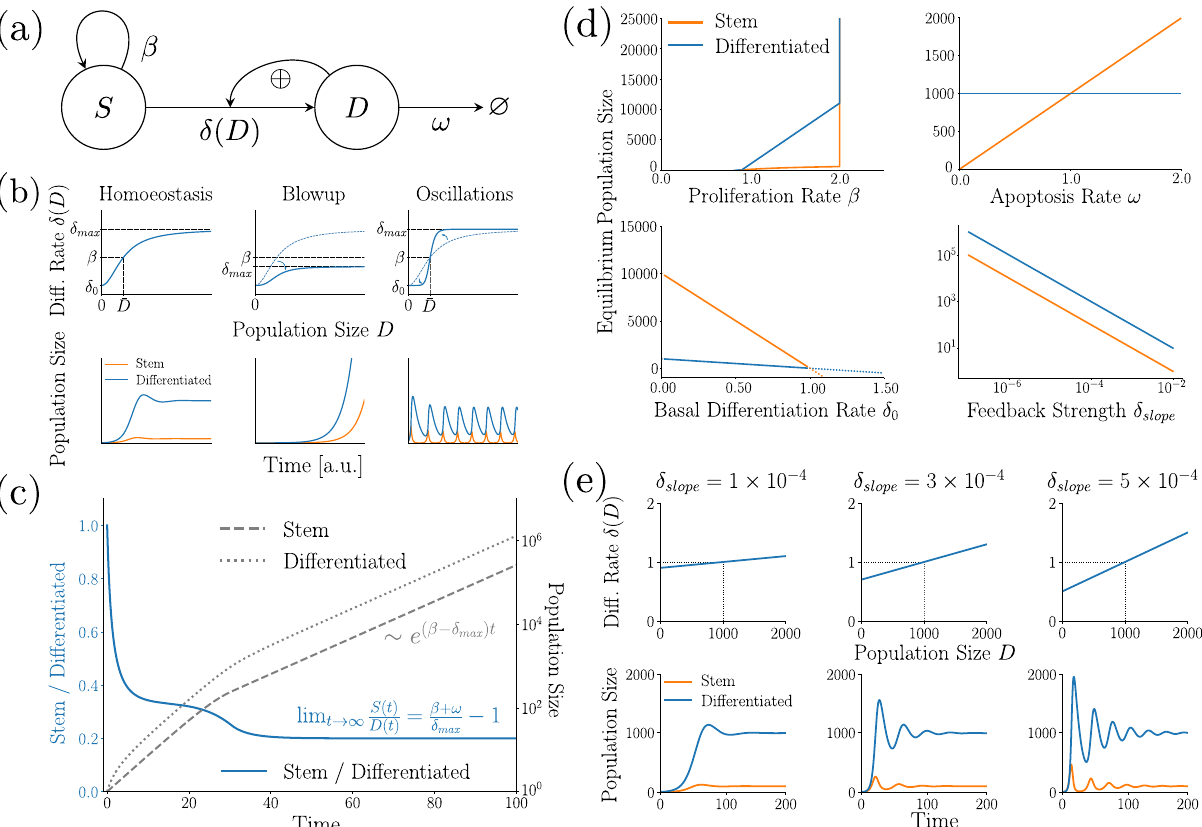
Figure 1. The basic colon epithelium model. (a) Schematic sketch of the model. (b) The feedback function δ (upper row) determines the qualitative behaviour of the model (lower row). First column: Stable steady state. Second column: unbounded growth. Third column: sustained oscillations. The little arrows represent changes to the feedback function compared to the first column. The dotted line in the second and third column shows the feedback function from the first column for easier comparison. (c) In case of explosive growth, the system converges to a stable ratio of stem to differentiated cells. Exemplary numerical integration. (d) Bifurcation diagram of the system with linear feedback function δ . Standard parametrisation: β = 1.0, ω = 0.1, δ 0 = 0.9, δ slope = 10 − 4 , δ max = 2.0 . Note the switch from a stable steady state to unbounded growth for β > δ max (upper-left panel ). Also note the invariance of ¯ D to changes in ω (upper-right panel).